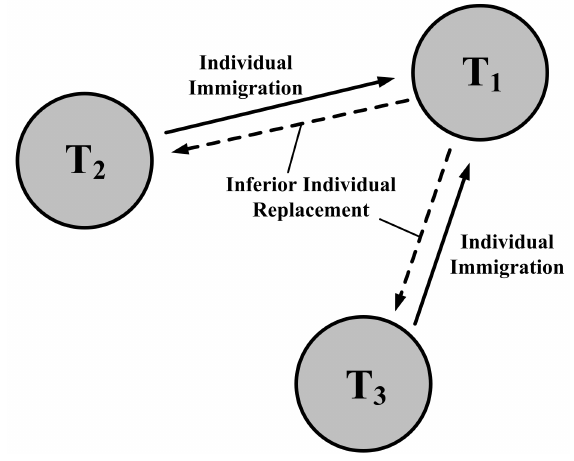
Figure 9. An illustration of the multipopulation technique for multitask optimization [131].